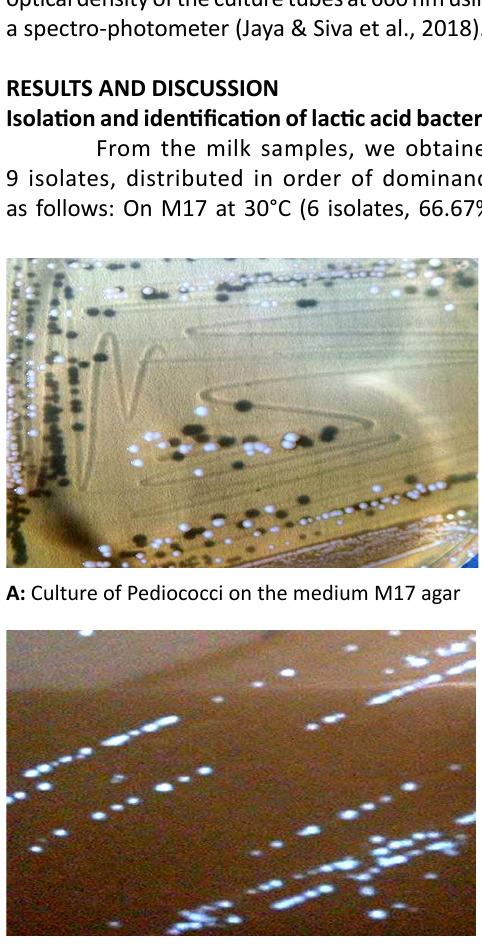
C: Lactobacillus culture on MRS agar medium D: Culture Lactococcus on the medium M17 Fig. 1. Macroscopic appearance of lactic strains